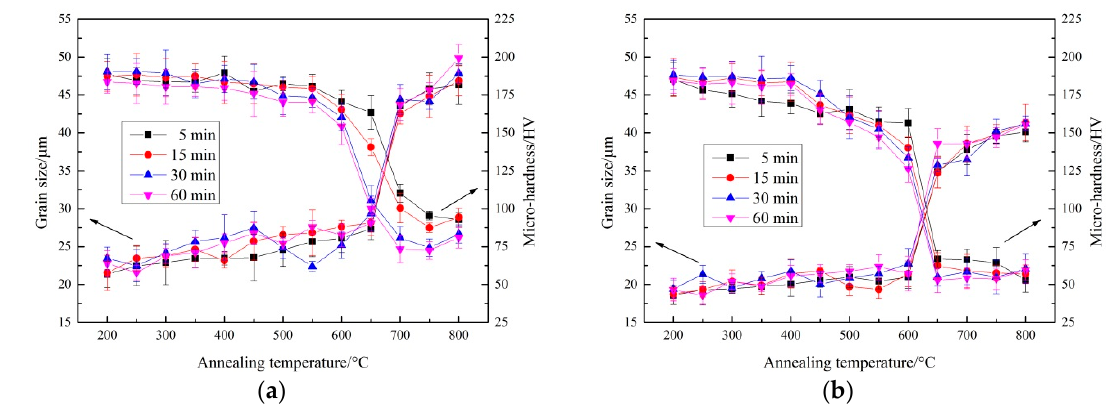
Figure 8. Variation of grain size and micro-hardness of CGP nickel sheets against annealing temperatures and time: ( a ) Pass 1; ( b ) pass 2.